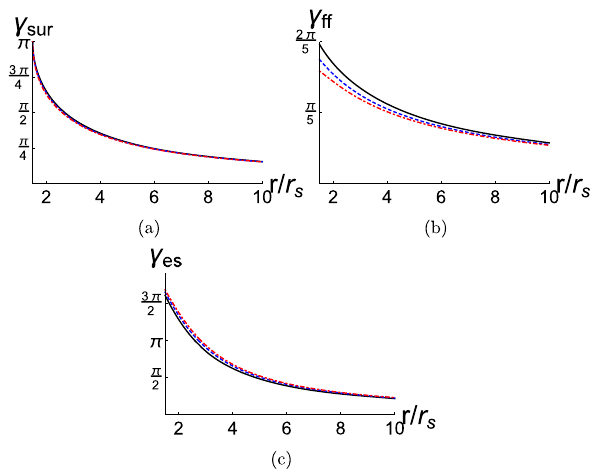
Fig. 3 Theangle γ asafunctionoftheradialdistance r / r S .Theparam- eter r B is set to r B = 0 (the black solid lines), r B = 0 . 5 r S (the blue dashedlines),and r B = 0 . 8 r S (thereddotdashedlines). a Thesurround- ing observer. b The freely falling observer. c The escaping observer